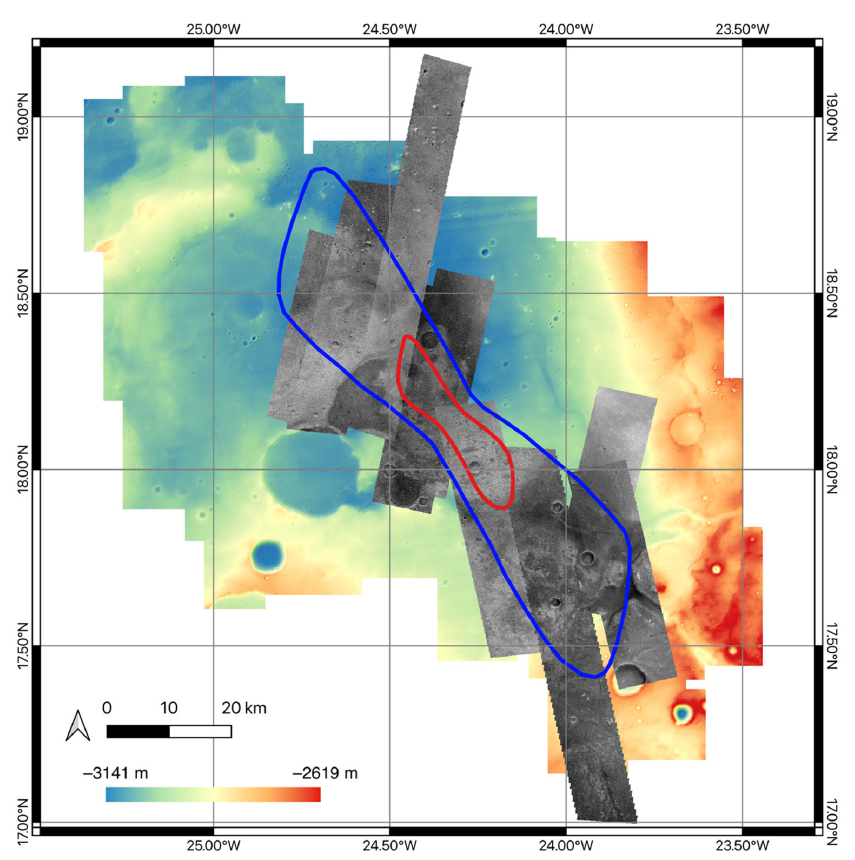
Figure 2. An overview map of the 9 test CaSSIS images (co-registered with the CTX and HRSC ORIs [28]), superimposed on the CTX MADNet DTM mosaic (baseline reference), over the Exo- Mars Rosalind Franklin rover’s landing site (1-sigma ellipse: red; 3-sigma ellipse: blue) at Oxia Planum [28,62,63] (centred at 18.239 ◦ N, 24.368 ◦ W; map projection: Mars